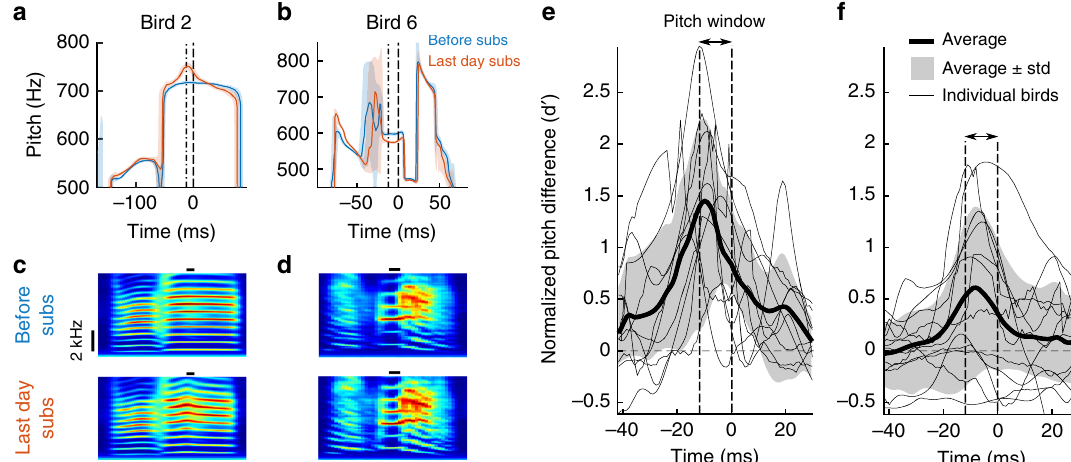
Fig. 3 Within-syllable pitch trajectories show time-localized learning. a , b median (solid line) and quantiles (shaded area) of within-syllable pitch during baseline (blue) and on the last day of substitution (last day subs, red) in a subs-high ( a ) and a subs-low bird ( b ). The two dashed vertical lines show the window within which we calculated pitch to determine whether to switch off the light or not. The bird numbers correspond to target syllable numbers in Fig. 1g. c , d Average spectrogram of the targeted syllable before (top row) and after (bottom row) the substitution paradigm. Same time axis as in ( a ). The horizontal black bar indicates the pitch calculation window. e , f Traces of normalized pitch differences between (the last day of) baseline and the last day of subs in deaf subs ( e ) and in hearing LO birds ( f ). Birds adapted pitch within about 10 ms of the pitch calculation time window (delimited by dashed vertical lines). The fi ne curves show pitch difference traces in individual birds, the thick curve their average, and the gray area indicates the average ± one standard deviation. Curves in birds that decreased pitch are fl ipped to make pitch changes